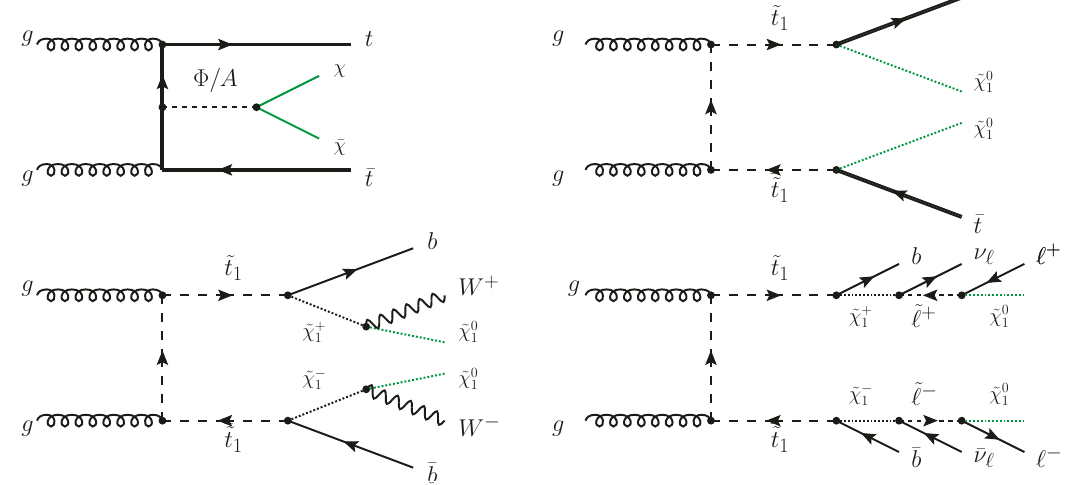
Figure 1 . Representative Feynman diagrams for DM production (the (cid:12)rst diagram) and for super- symmetric models with supersymmetric partners of the top quarks that might contribute to beyond the SM pp t (cid:22) t + p miss production at the T !